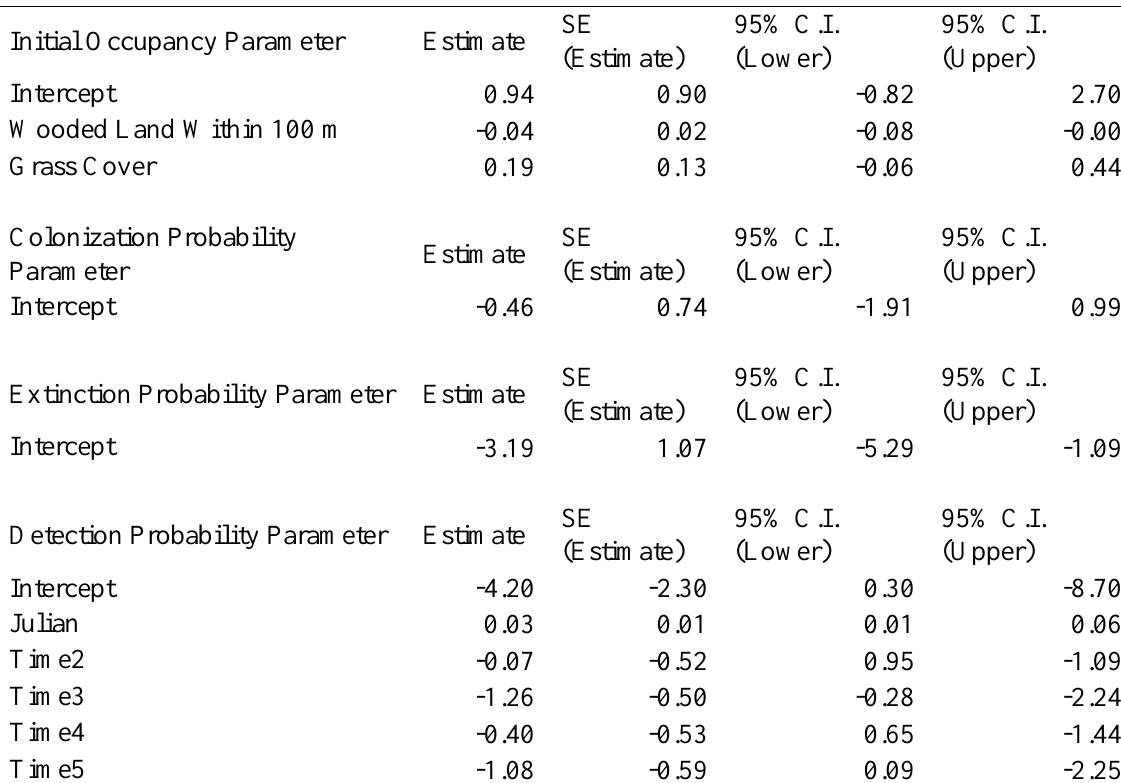
Table A3.A. Second-highest-ranking multi-season occupancy model (AIC ∆ AIC =0.00, AIC weight=0.12) for Clay-coloured Sparrows along 47 transmission line study c sites in Winnipeg, Manitoba, Canada in 2008-2009 (n=276 surveys), assuming no effect of mowing on probability of colonization or extinction, and effects of Julian date and time of morning but not observer experience on probability of detection given presence at sites.